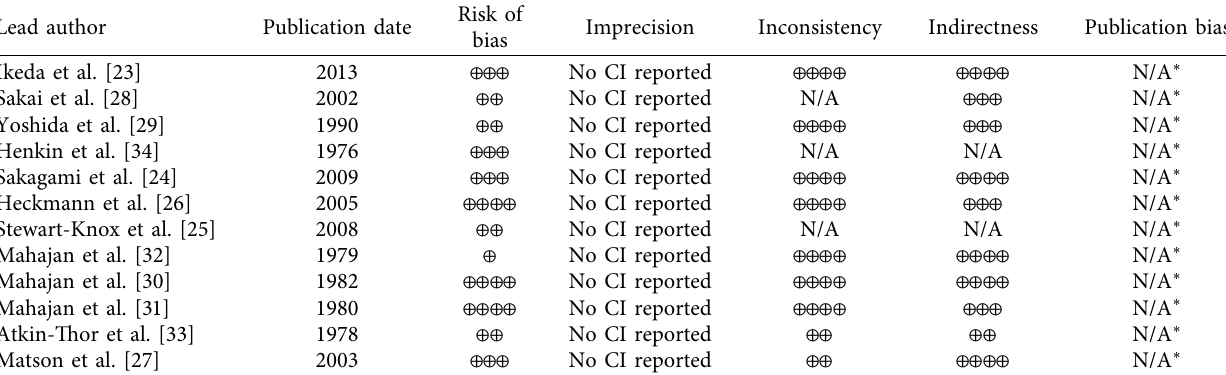
Table 4: A systematic review meta-analysis—GRADE score results for all.